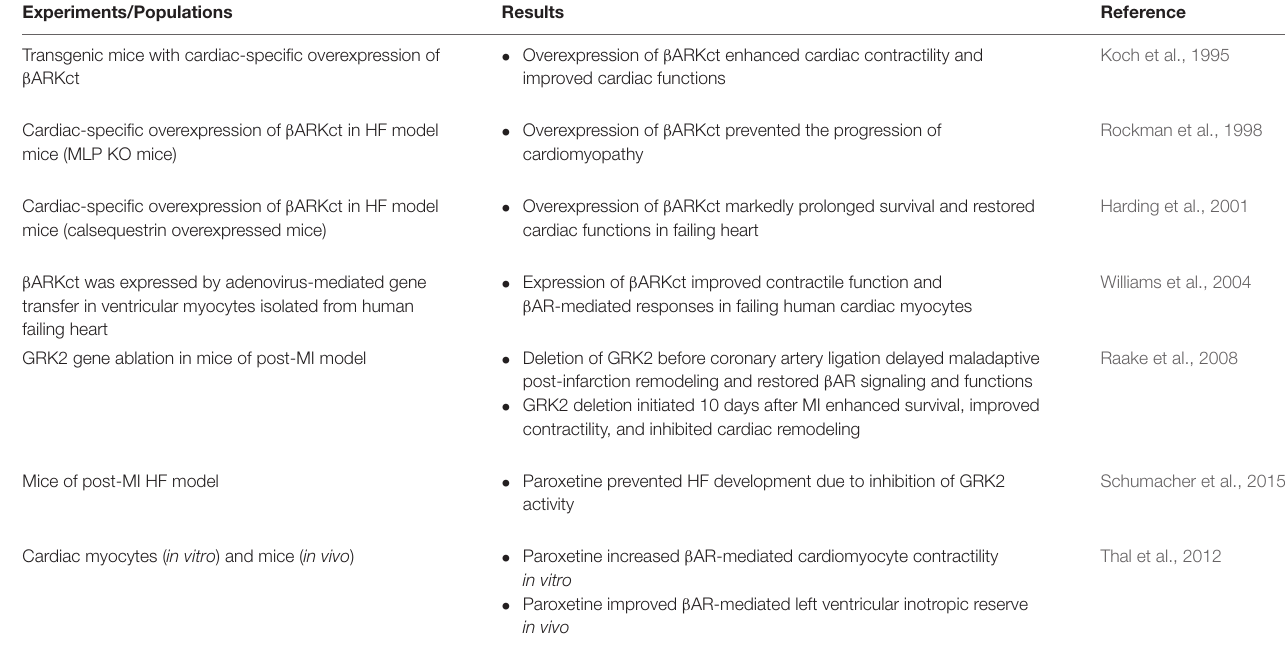
TABLE 2 | GRKs as the therapeutic targets for HF